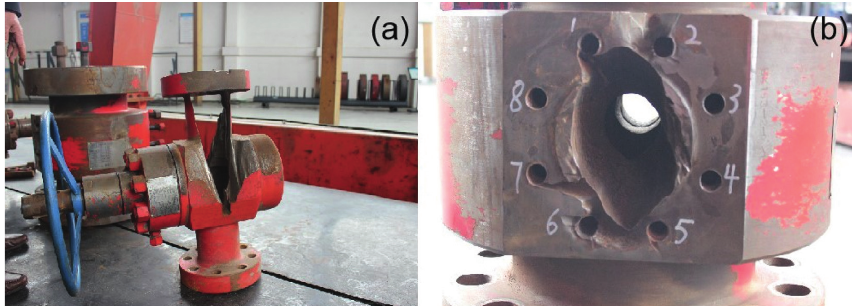
Figure 2: (a) Failure morphology of No. 3 valve body; (b) failure morphology of the joint between the cross and No. 3 valve.